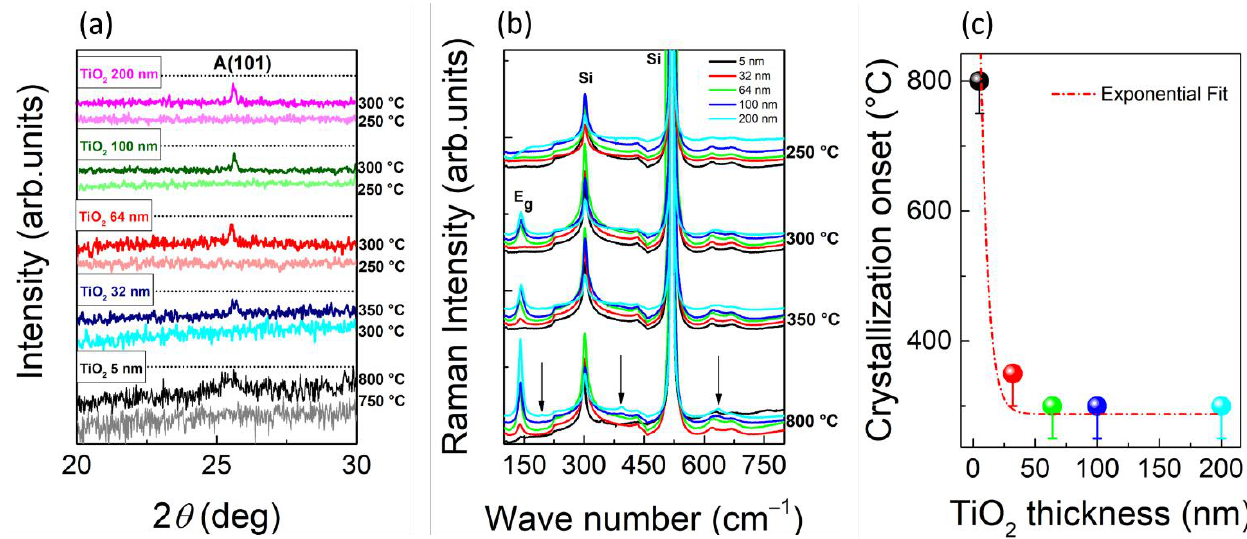
Figure 3. ( a ) XRD spectra of the 200 nm sample at 250 (light magenta) and 300 °C (magenta), the 100 nm sample at 250 (light green) and 300 °C (green), the 64 nm sample at 250 (light red) and 300 °C (red), the 32 nm sample at 300 (light blue) and 350 °C (blue), and the 5 nm sample at 750 (grey) and 800 °C (black). The symbol A indicates the anatase phase; ( b ) Raman Spectra of the 5 (black), 32 (red), 64 (green), 100 (cyan), and 200 (blue) samples annealed at different temperatures (250, 300, 350, and 800 °C); ( c ) crystallization onset temperature as a function of the TiO 2 thickness. The red dashed line is the exponential fit.